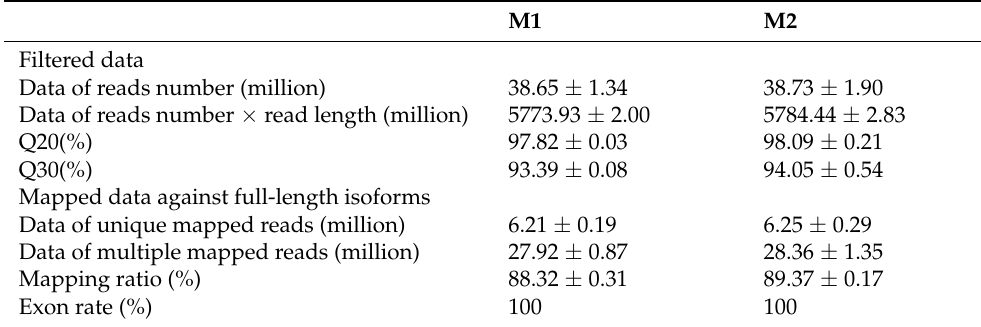
Table 2. Summary of sequencing data of M1 and M2 (mean ± SD, n =